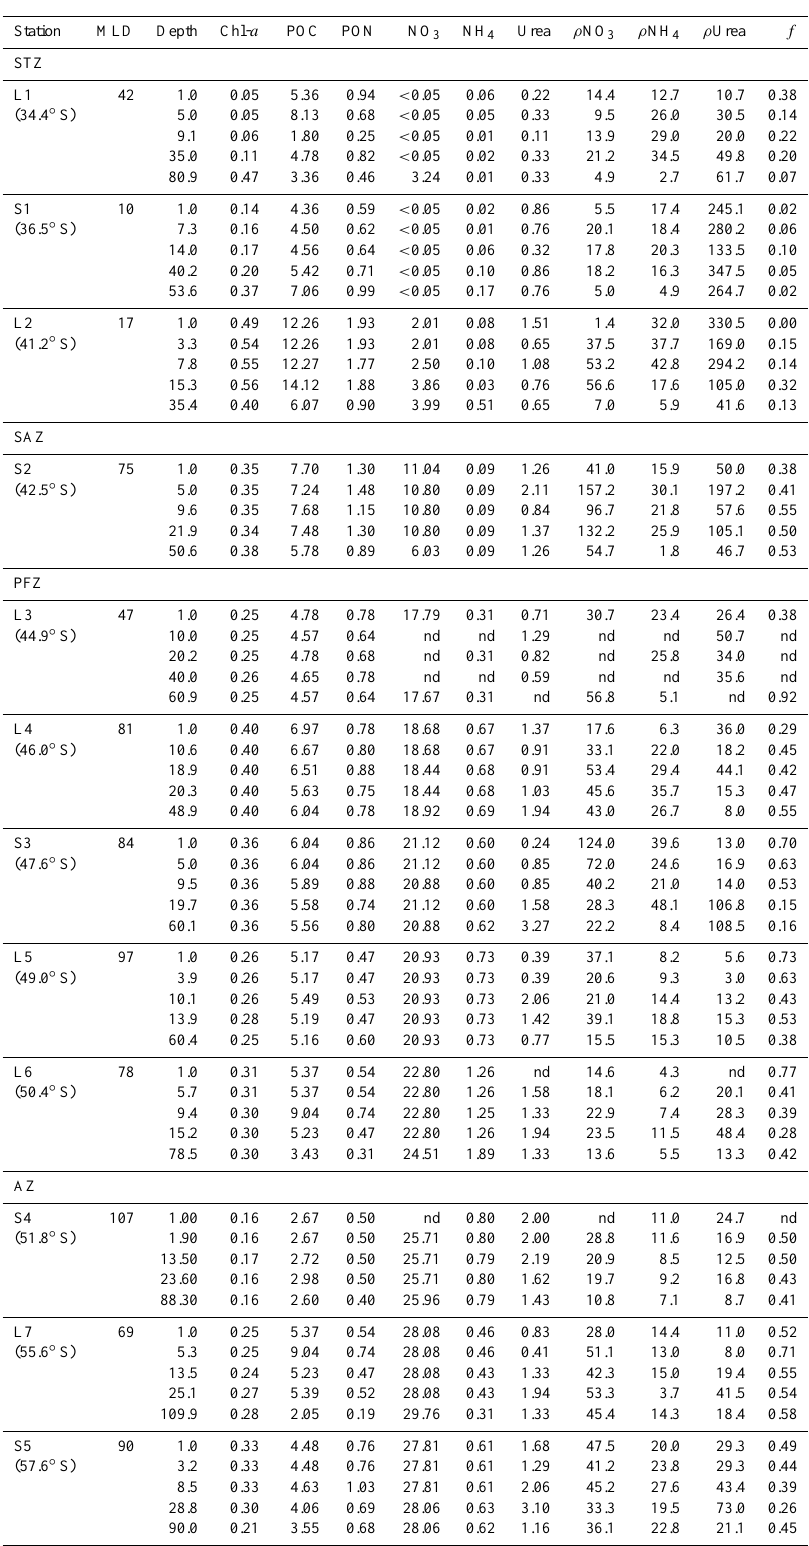
Table 2. List of data at each sampling station (including latitude positions) during the BGH cruise (MLD; m, sample depth; m, chl- a , µgl − 1 ; POC and PON, µmoll − 1 ; nutrients, µmoll − 1 ; ρ N, nmol l − 1 d − 1 ) . The five sample depths at each station represent, with increasing depth, the 100%, 50%, 25%, 10% and 1% light depths. nd indicates no